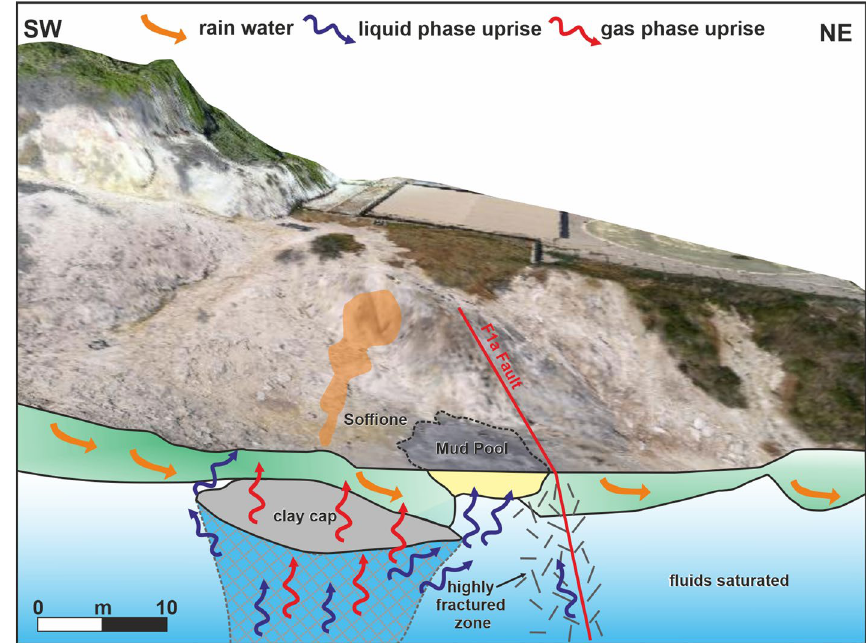
Figure 8. Structural setting of the PFF feeding system. The figure was created using the Visit 3.1.2 open-source software (https:// wci. llnl. gov/ simul ation/ compu ter- codes/ visit) produced by the Lawrence Livermore